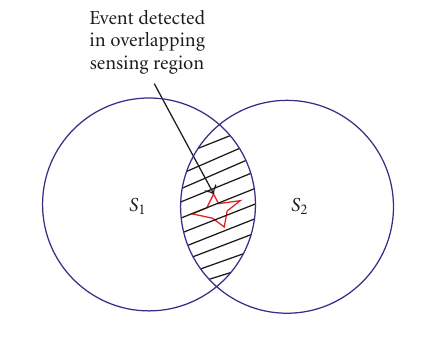
Figure 3: Overlapping sensing region for key